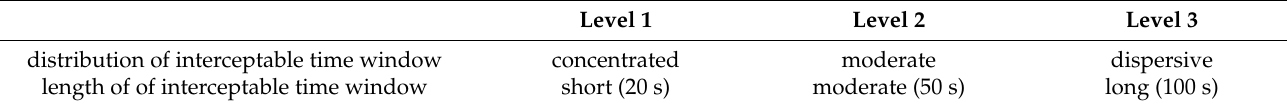
Table 2. Interceptable time window test factor level